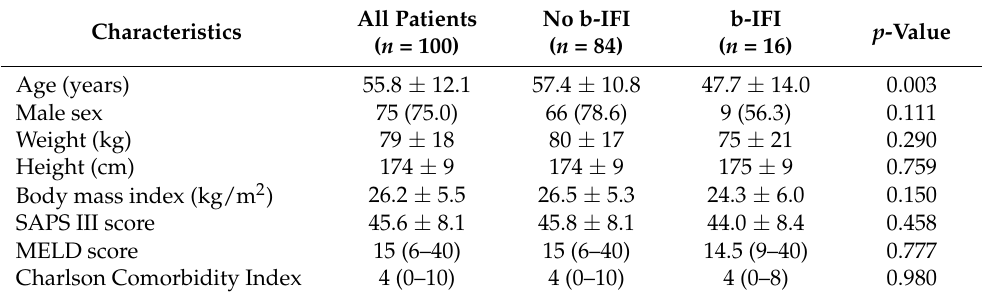
Table 1. Sociodemographic and clinical characteristics, including the perioperative risk factors for b-IFI ( n = 100).